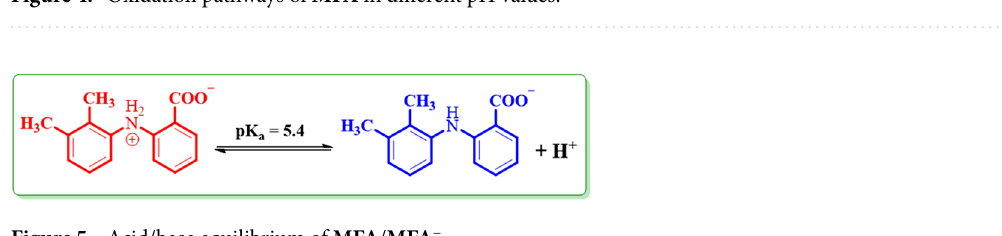
Figure 5. Acid/base equilibrium of MFA / MFA −